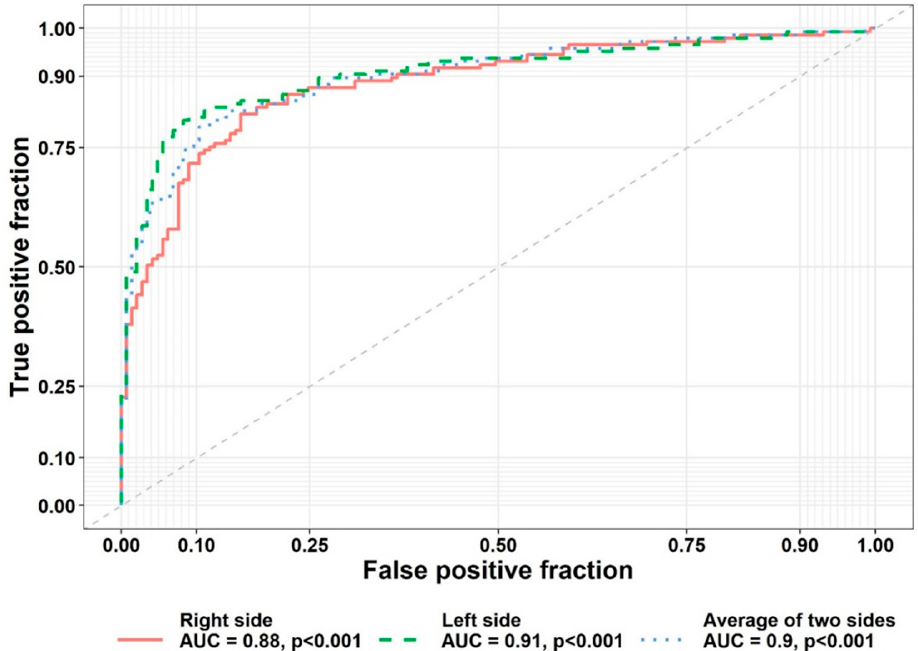
Figure 4. Receiver operating characteristic curve for sensitivity of the formula.